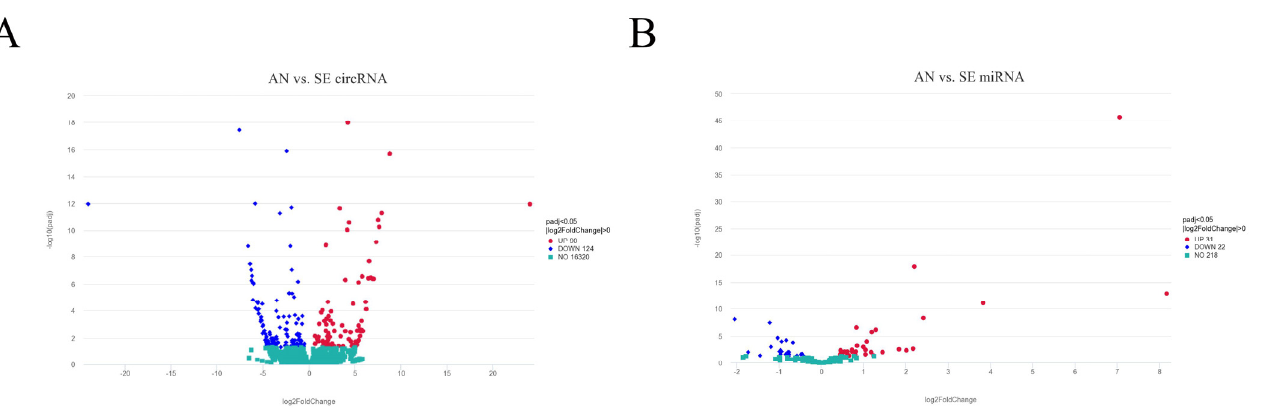
Figure 3. Top annotated GO terms ( A ) and top enriched KEGG pathways ( B ) of source genes of DE circRNAs. Top annotated GO terms ( C ) and top enriched KEGG pathways ( D ) of target genes of DE miRNAs.